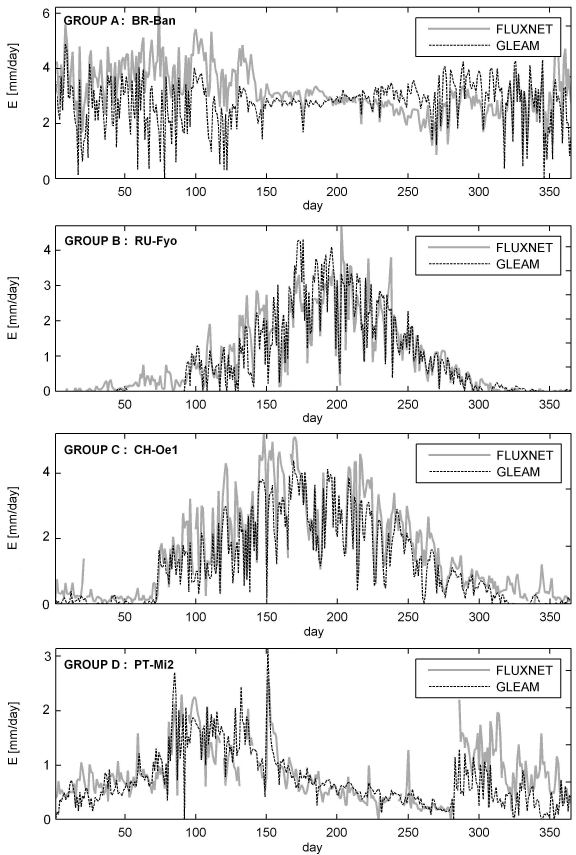
Fig. 6. Examples of daily time-series of FLUXNET and GLEAM E (in mm) from each of the four groups defined in Sect. 4.2.1